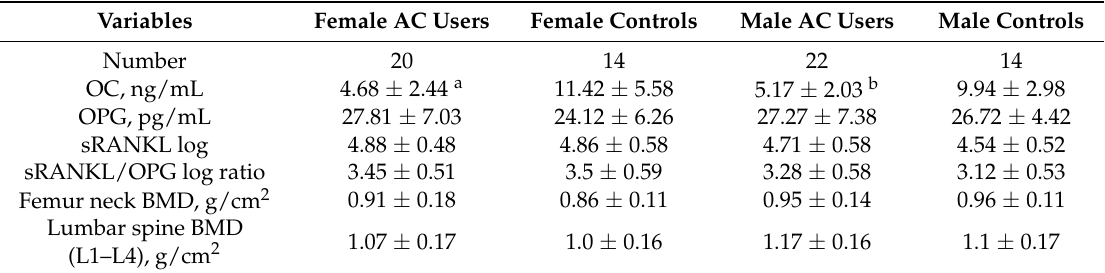
Table 2. The influence of gender and the use of AC on the level of the examined variables in female and male AC users and